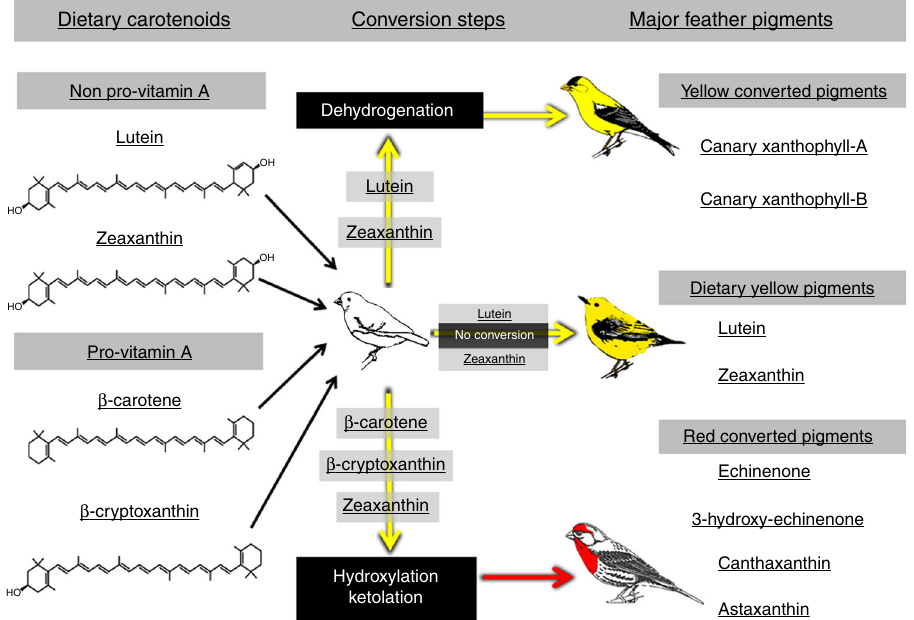
Fig. 1 Carotenoids used for feather coloration. To produce feather coloration, passerine birds either use dietary carotenoids unaltered or use carotenoid pigments that are metabolically derived from dietary pigments. Depicted are the proposed metabolic pathways by which the common dietary carotenoids in the diets of passerine birds can be converted into the red and yellow ketolated carotenoids found in feathers 16,79,80 . Birds shown are representative of coloration from converted and dietary carotenoids. House fi nch (lower) use converted red carotenoids, American gold fi nch (upper) display converted yellow carotenoids, and wood warblers (middle) display dietary yellow carotenoids. A few bird species directly ingest red carotenoids, such as astaxanthin, from their diet (not